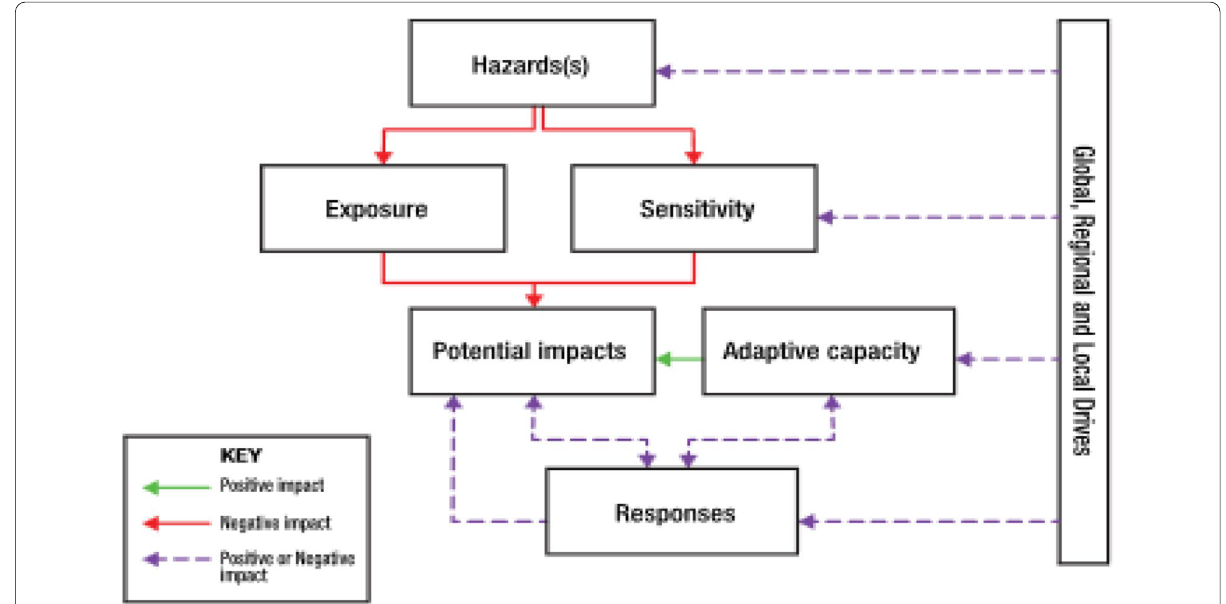
Fig. 4 A framework for understanding urban vulnerability to climate change